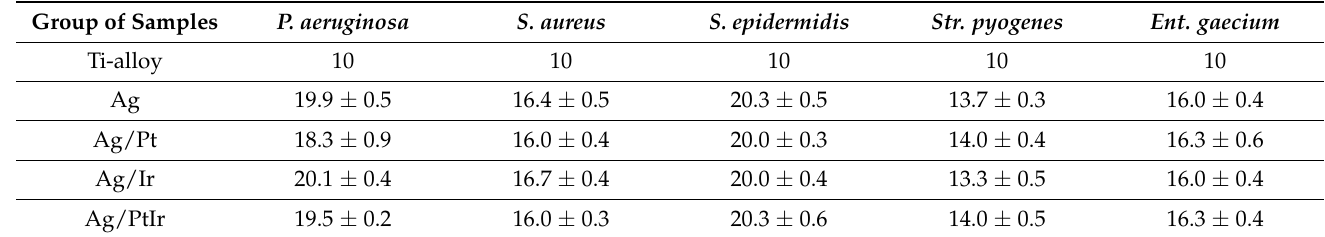
Figure 9. Bacterial growth inhibition assay ( P. aeruginosa ) for Ir ( a ) and Ag/Ir ( b ) samples; blue circle—zone of inhibition. The remaining samples were standard discs with control antibiotics (cefepime, imipenem, and tobramycin). Table 1. Diameter of bacterial growth inhibition zone